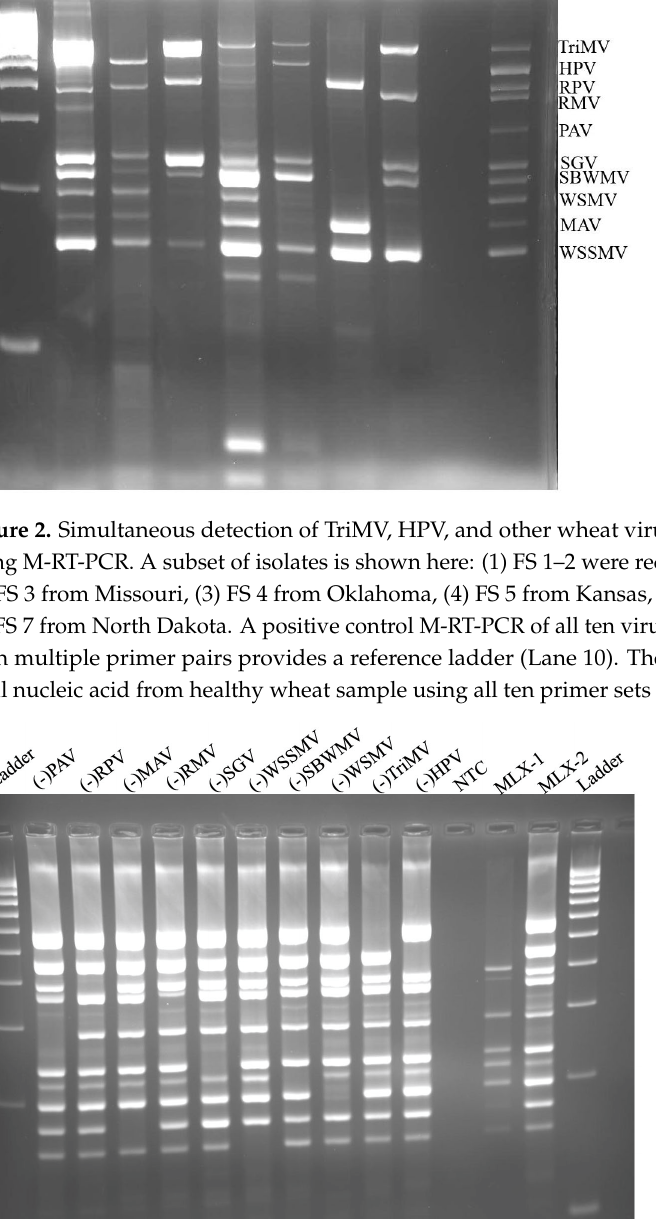
Figure 3. Specificity of the primers. Multiplex RT-PCRs (MLX) were carried out with a pool of control virus samples. A set of virus-specific primers were sequentially deleted from each M-RT-PCR (Lanes 2–11). M-RT-PCR without the TriMV-specific primers shows no band for TriMV (Lane 10) and amplification without HPV primers did not give HPV band (Lane 11). This can be visually compared with the control eight- and ten-virus multiplex (Lane 13 and 14, respectively). Lanes 1 and 15 contain a 100 bp molecular marker ladder for reference.